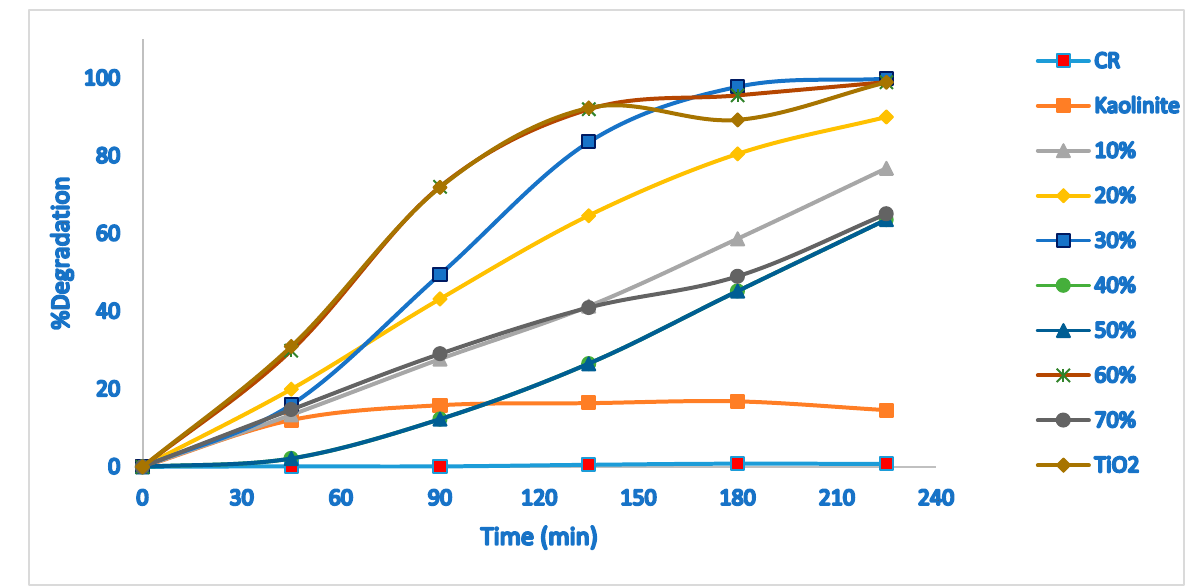
Figure 4. Photocatalytic degradation of CR under sunlight irradiation at various TiO 2 percentages; CR, Kaolinite, X% (X = 10, 20, 30, 40, 50, 60, 70): percentage of TiO 2 in TiO 2 –JK NC. Initial dye concentration is 20 ppm; photocatalyst dosage is 0.1 g.